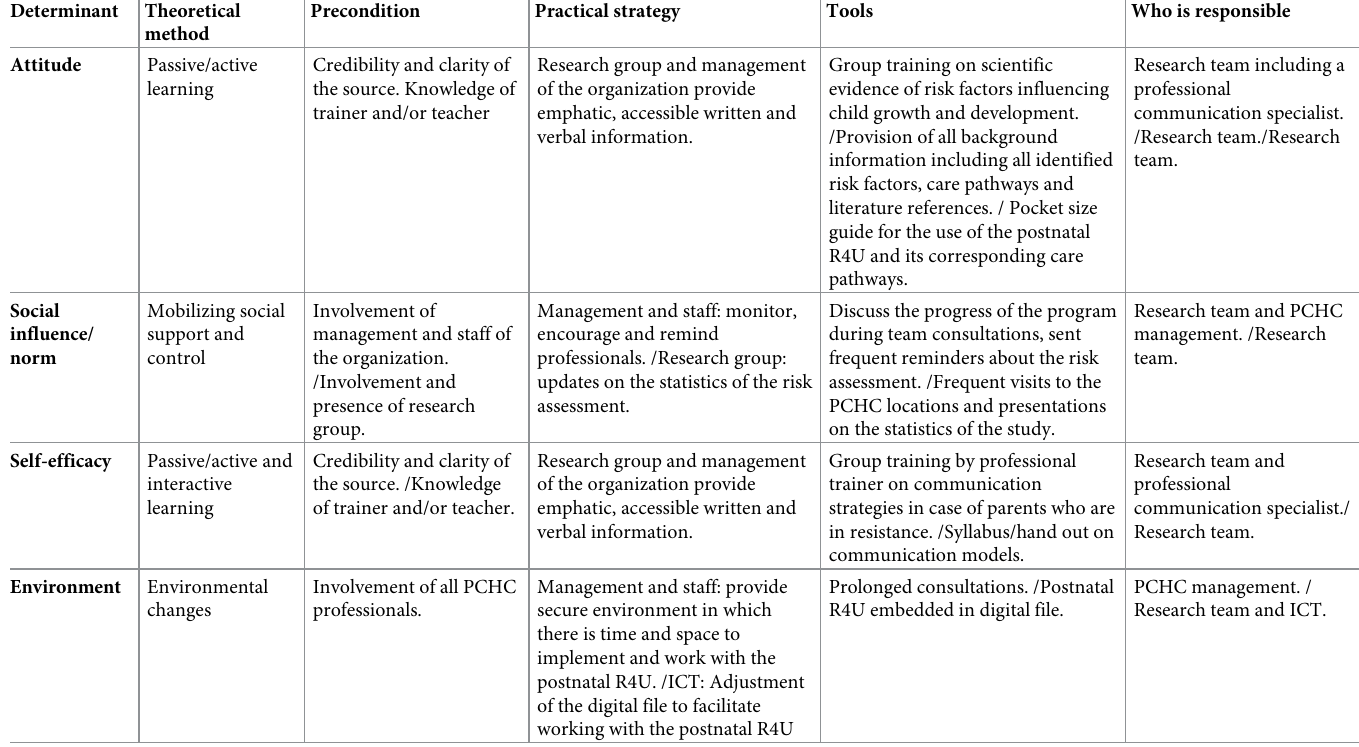
Table 1. Personal and environmental determinants according to the ASE model, theoretical methods, preconditions, practical strategies and tools for the design and implementation of the postnatal risk assessment and care pathways (Rotterdam, The Netherlands,